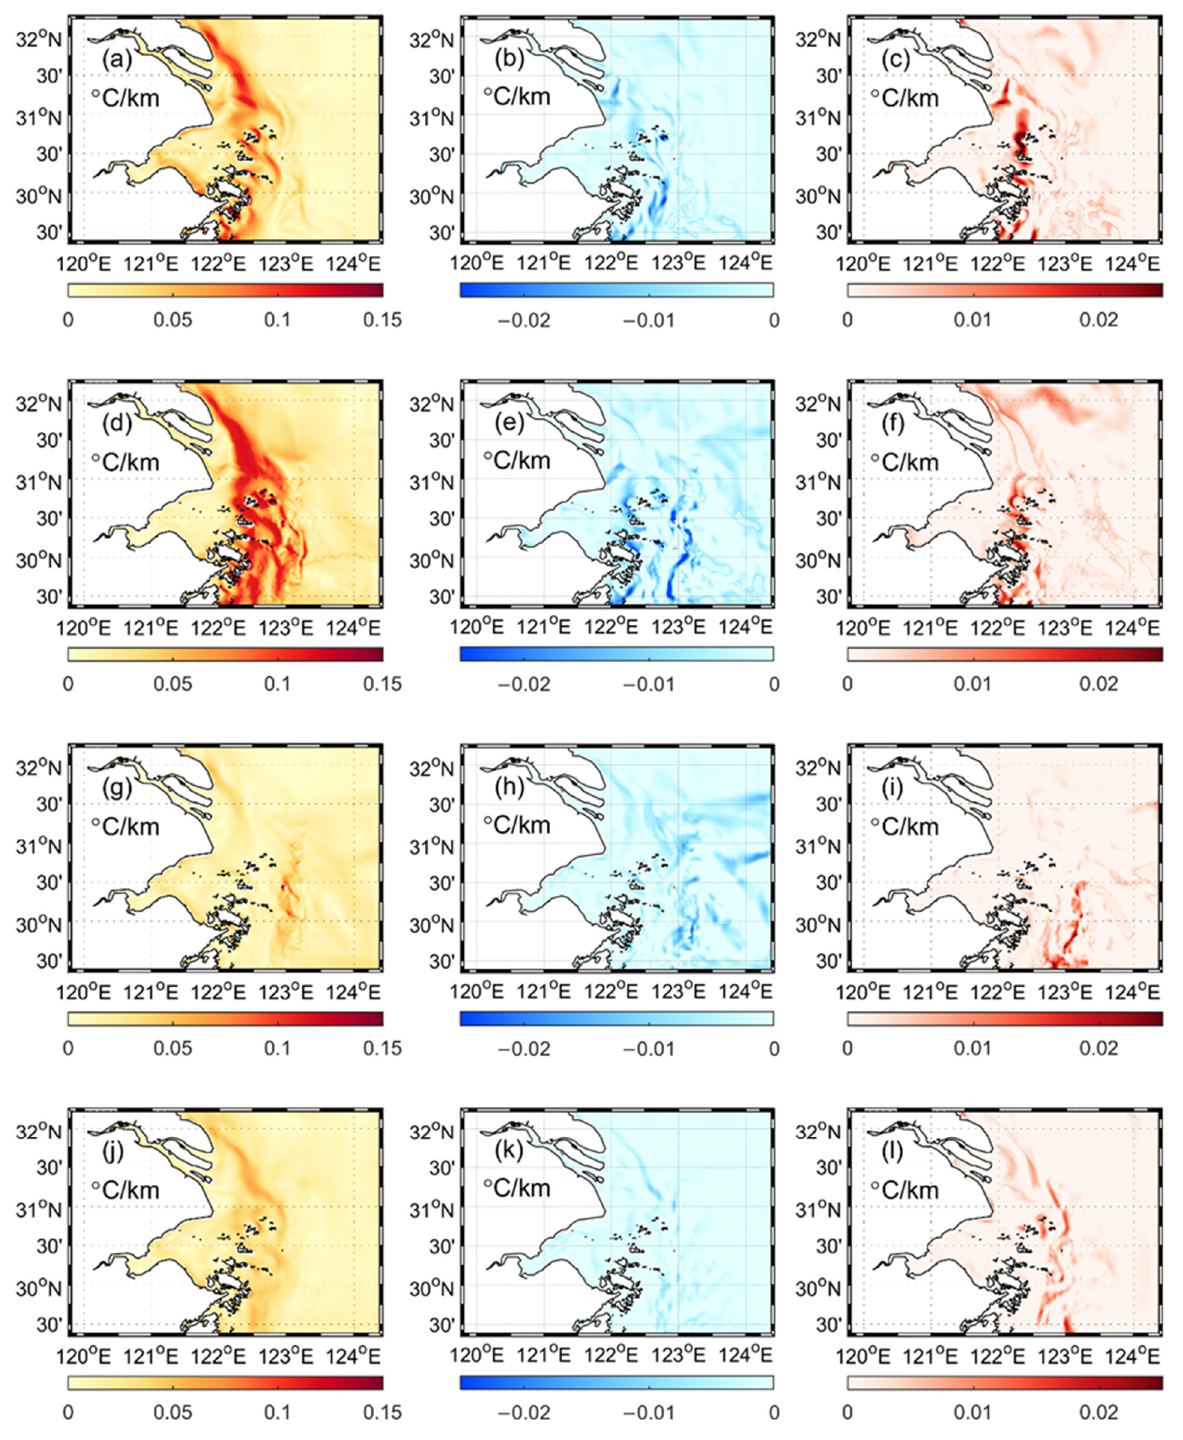
Figure 8. Influence of scarce or abundant situation of runoff on bottom fronts. ( a , d , g , j ) (case 1 results in Spring, Summer, Autumn and Winter); ( b , e , h , k ) (the difference between case 1 and case 5 in Spring, Summer, Autumn and Winter); ( c , f , i , l ) (the difference between case 1 and case 4 in Spring, Summer, Autumn and Winter).